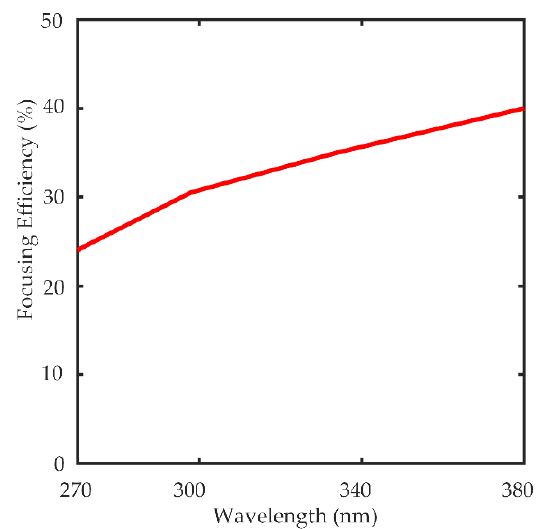
Figure 5. Focusing Efficiency of the metalens designed for the broadband UV spectrum 270–380 nm.